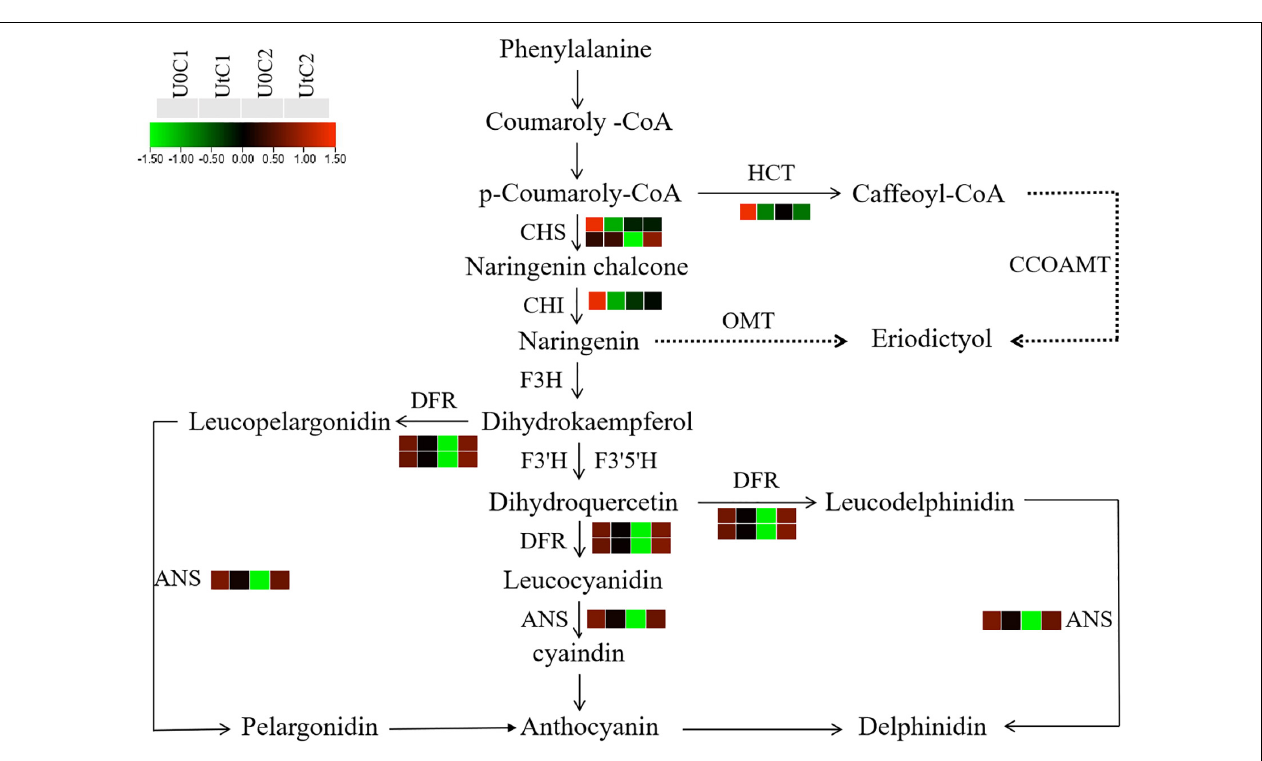
are similarly involved in the pathogen defense process of Meloidogyne and Oomycota, and this process is most likely independent of the SA pathway (Bhattarai et al., 2010). In our